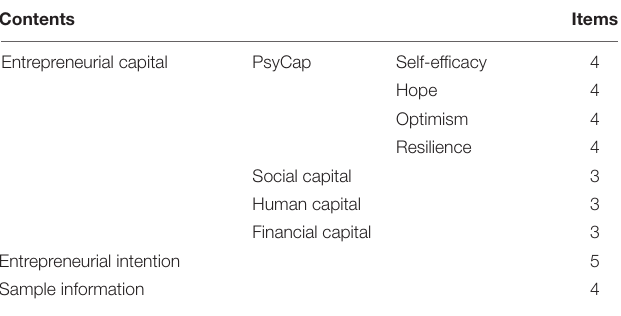
TABLE 1 | The structure of the